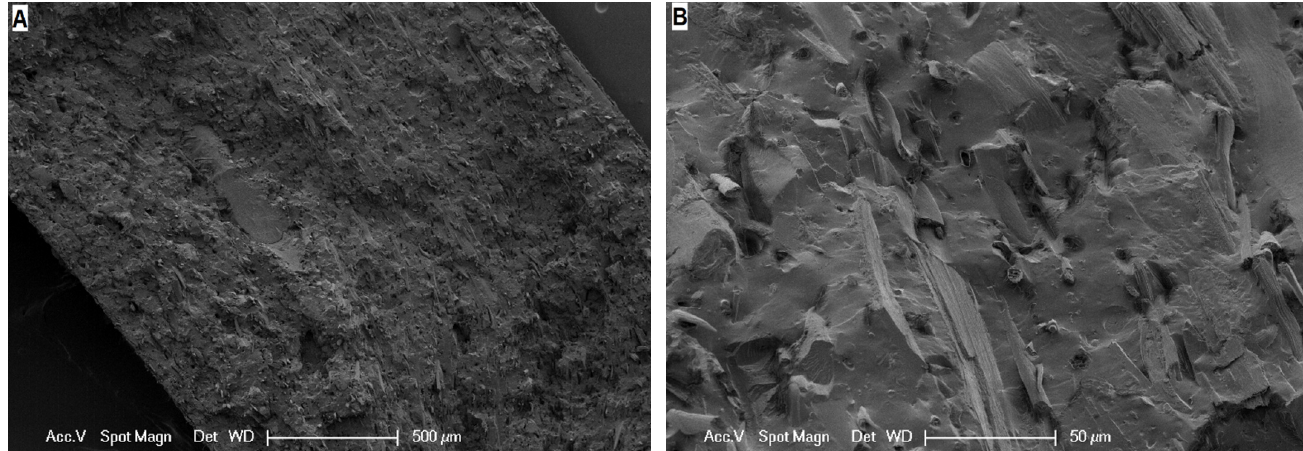
Figure 6. Scanning electron microscopy (SEM) images of a freeze fractured sample of M1 containing 100 phr of 0.08 mm feathers with 50× ( A ) and 500× ( B ) magnification.